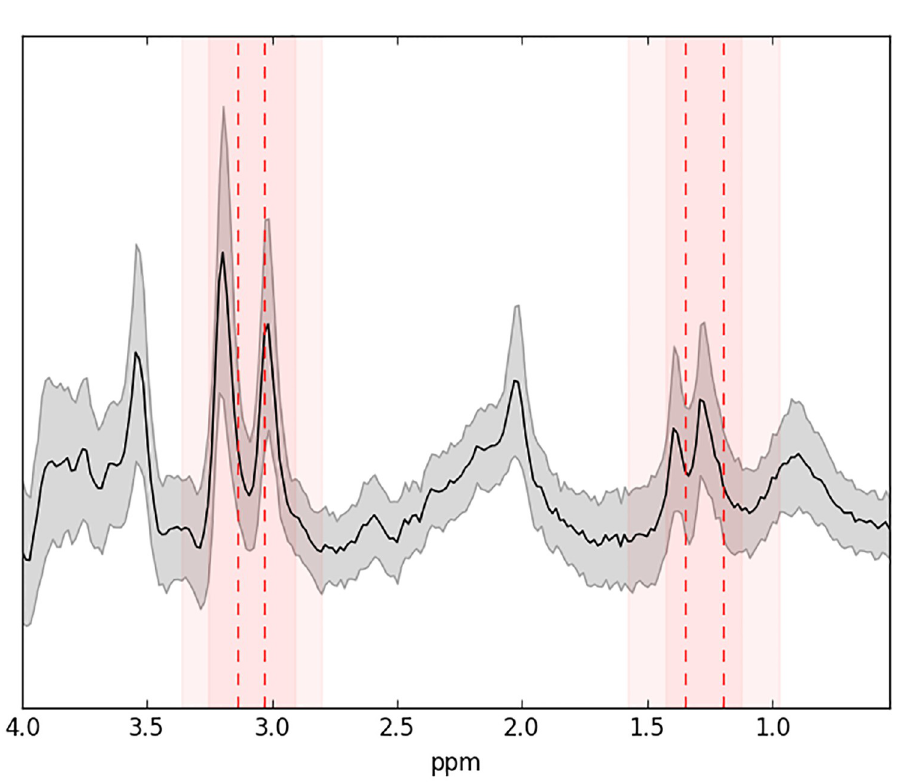
Fig 6. Important spectral regions for the separation of brain tumor dataset grade II vs grade III. The average spectrum for each area is plotted as a reference in (solid) black and the gray zone around it shows the standard deviation. The red dotted lines indicate the center of the most important regions (found by stability selection) and the red shaded areas around them indicate their size. These areas were obtained using stability feature selection on the output of the convolutional layer of the trained SL-CNN using only spectra as